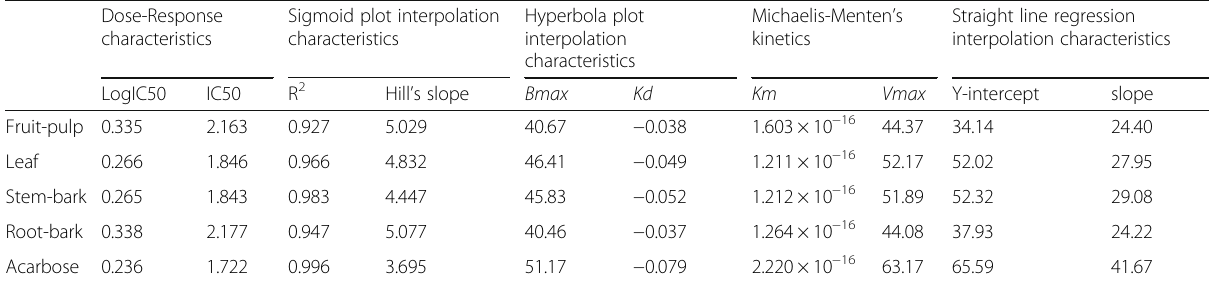
Table 3 Dose-response characteristics of the influence of Annona muricata methanolic extracts on α -amylase activity Dose-Response characteristics